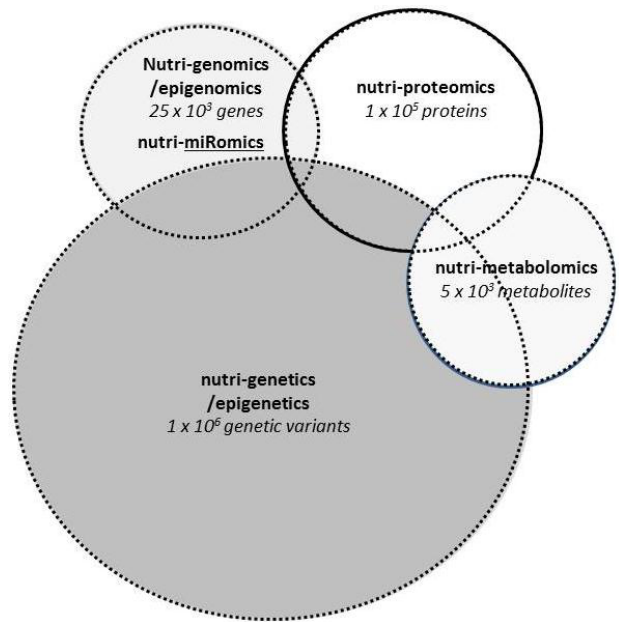
Figure 1. Proposed nutritional genomics mechanisms. The “Nutri-” prefix in the name of each of the 4 categories defines the influence of nutrition on genomics/epigenomics, proteomics, metabolomics and genetics/epigenomics.